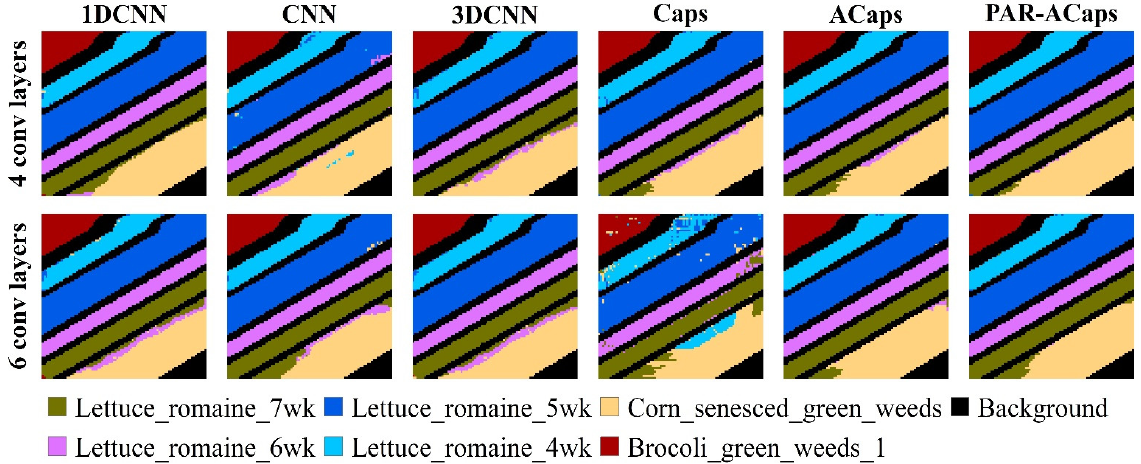
Figure 12. The classification results of SA dataset derived from 1DCNN, CNN, 3DCNN, Caps, ACaps, and PAR-ACaps with four and six convolutional